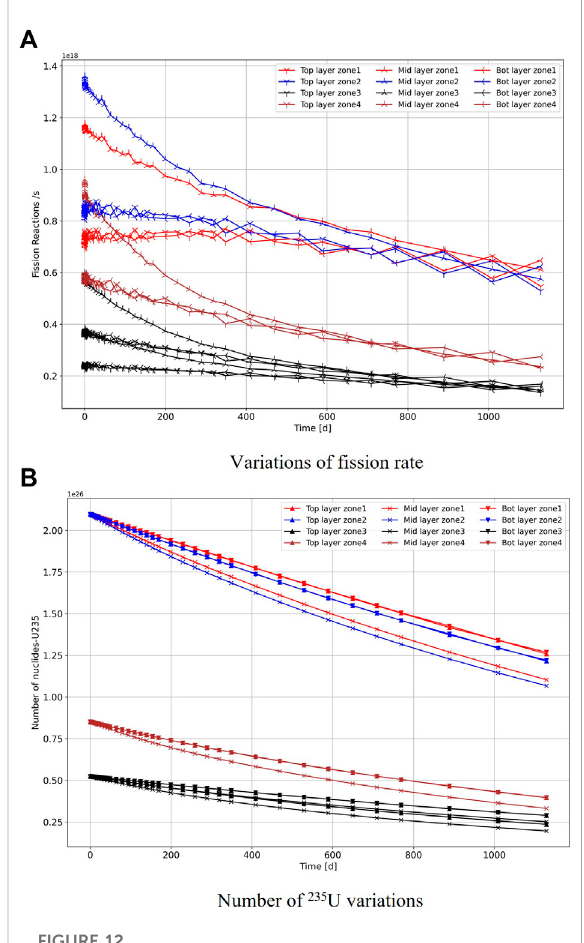
FIGURE 12 Burn-up results of 4 × 3 zones two batch refuelling scheme core, (A) fi ssion rate, (B) the number of 235 U.